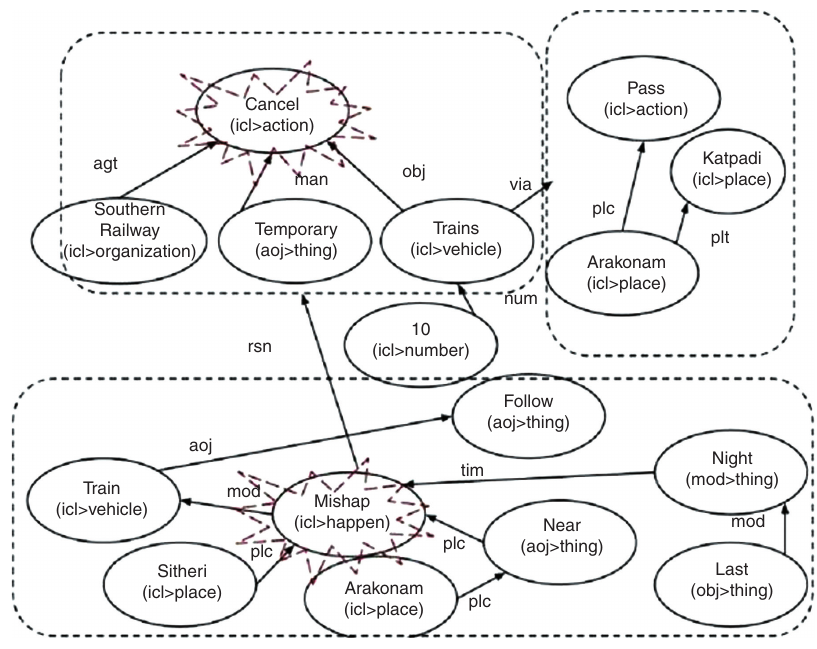
Figure 2. Semantic Graph-Based Representaion for Railway Accident.